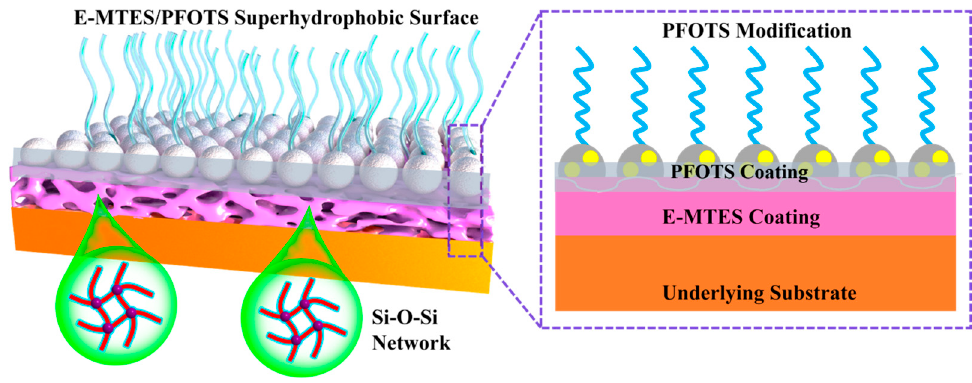
Figure 14. Illustration of the mechanism of the 2-layer coating structural design ( Left ), with enlarged interface structure ( right ).